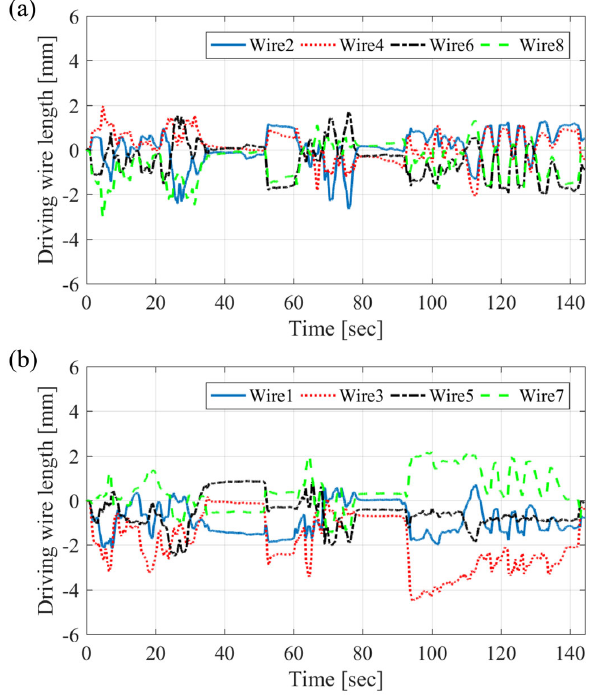
Figure 14. Driving wire length from the optimization path generator for ( a ) proximal joins and ( b ) distal joints.